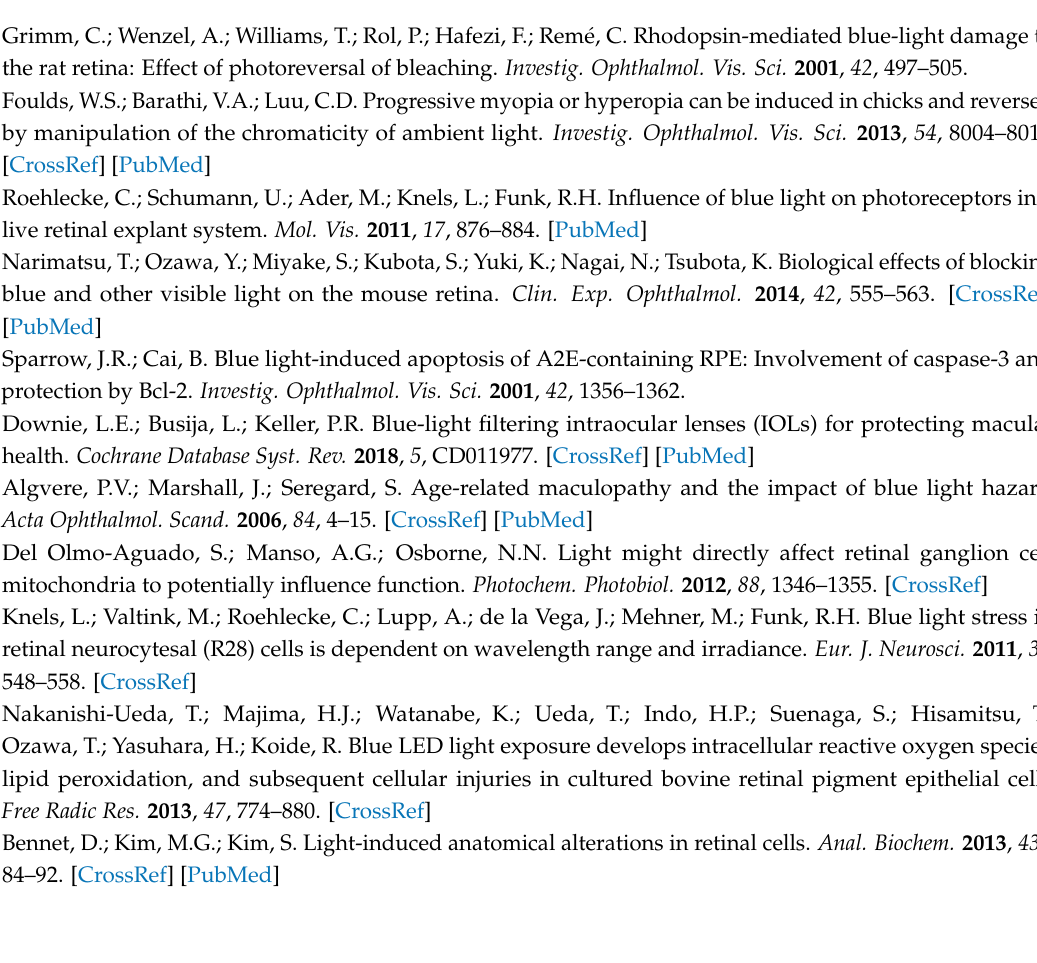
Figure S1: γ -H2AX foci label DNA double-strand breaks in retina neurons, Figure S2: γ -H2AX foci label DNA double-strand breaks in glia